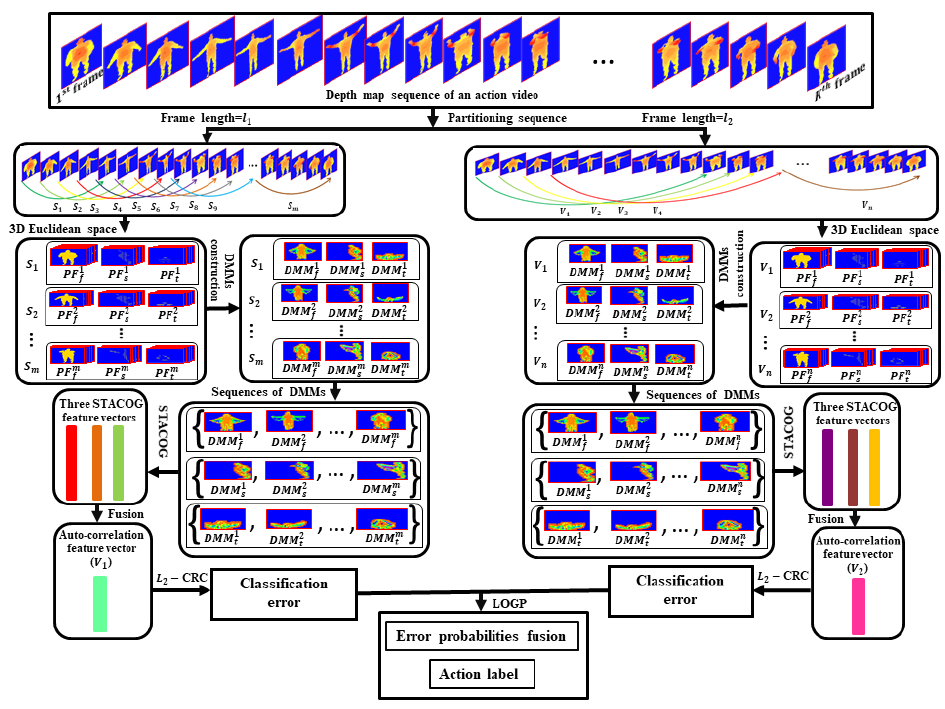
Figure 1. Proposed action recognition